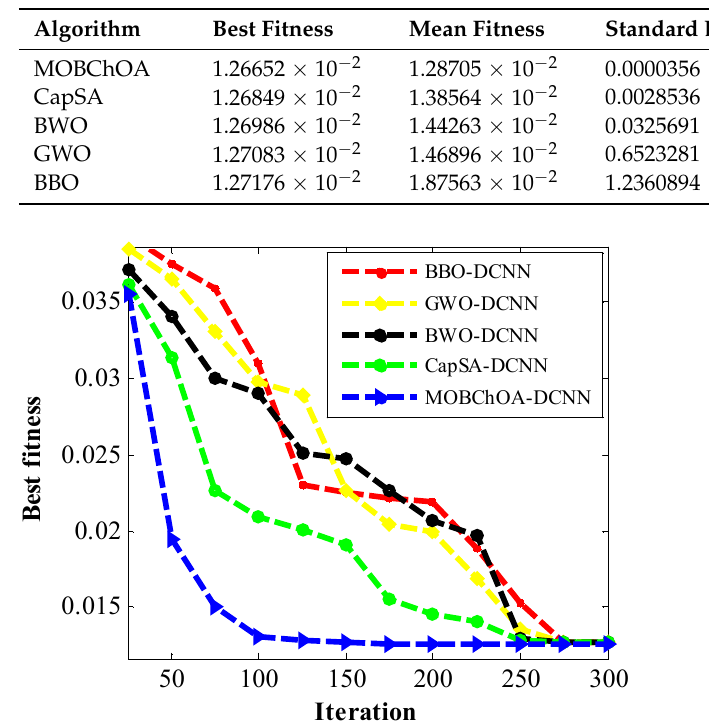
Figure 8. The convergence trends of algorithms for the spring system problem.